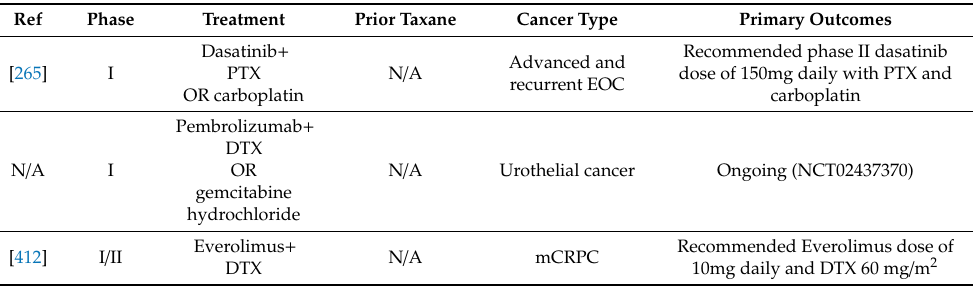
Table 4. Clinical trials of inhibitors to combat